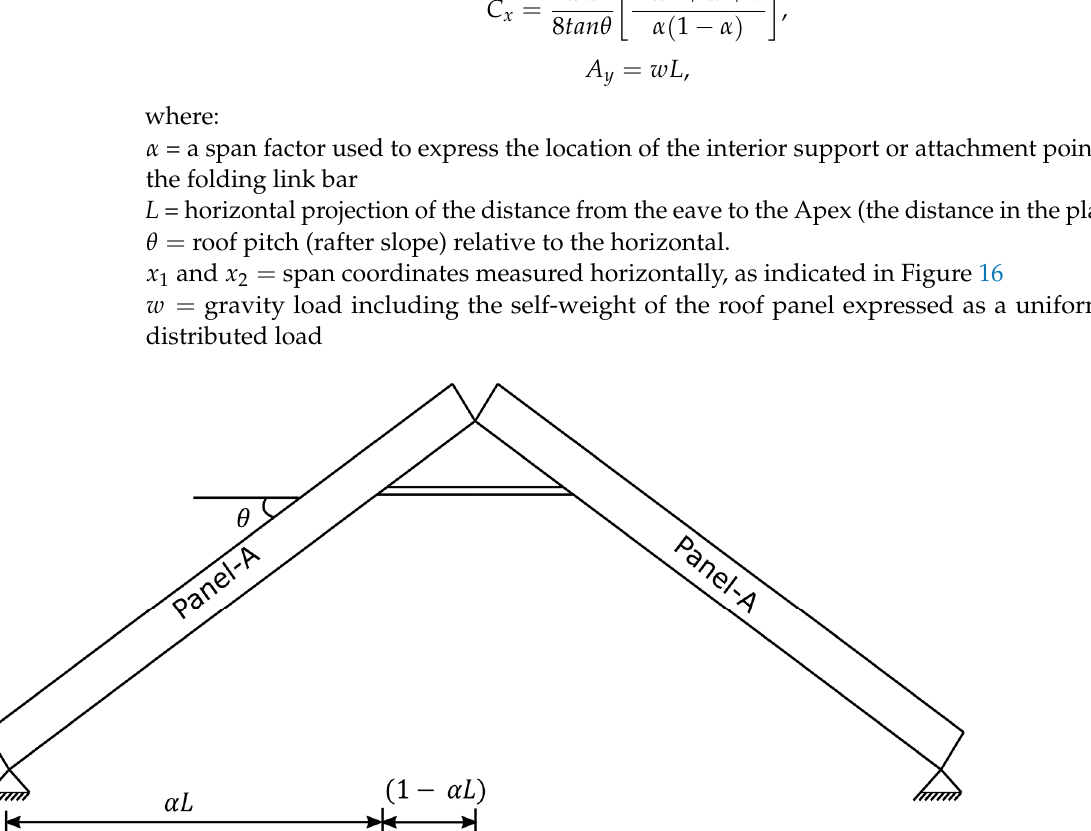
Figure 14. ( a ) Pin for connecting secondary bars at the apex point; ( b ) pin at the middle of the main link bar; and ( c ) Pin for sidebars.